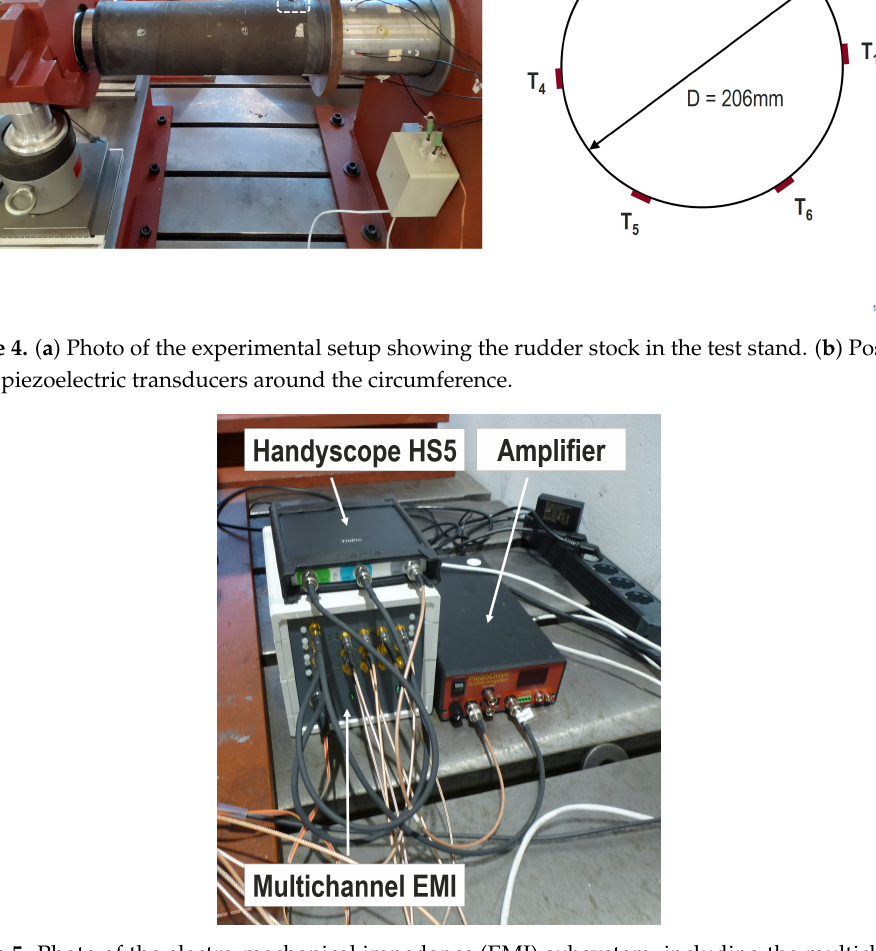
Figure 5. Photo of the electro-mechanical impedance (EMI) subsystem, including the multichannel EMI device, a Handscope HS5 for signal generation and A/D conversion and an ultrasound